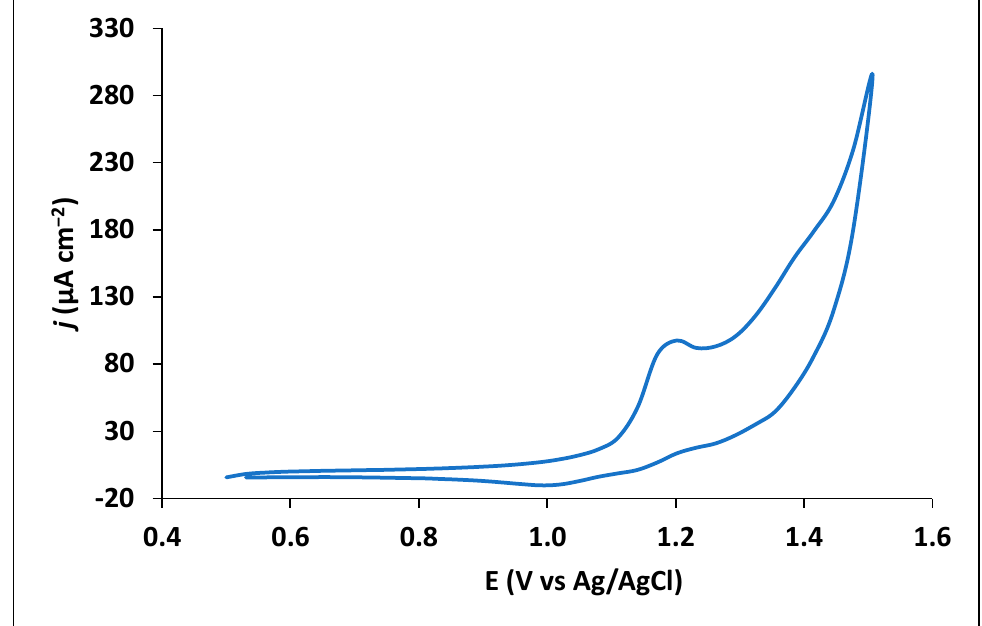
Figure 2. Cyclic voltammogram of 50 µM trimethoprim at 100 mV s − 1 . First scan.